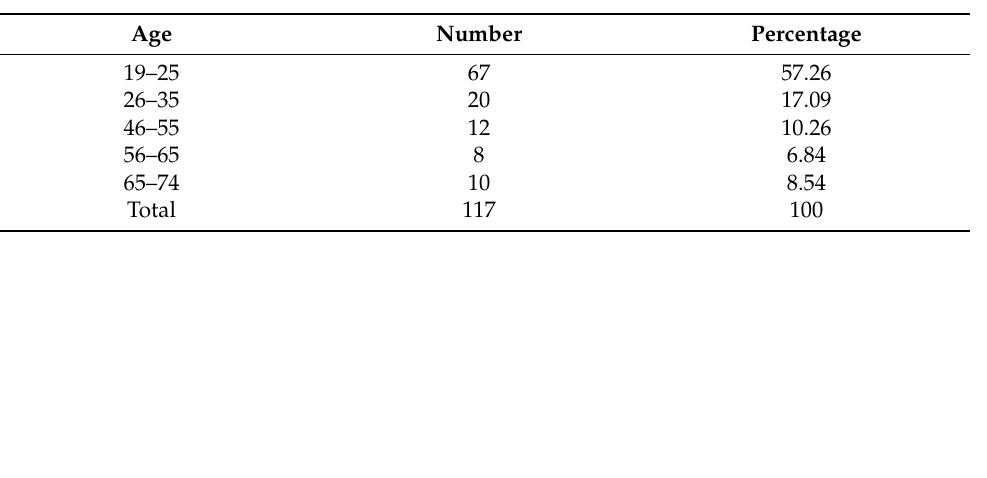
Table 1. Demographic characteristics of the